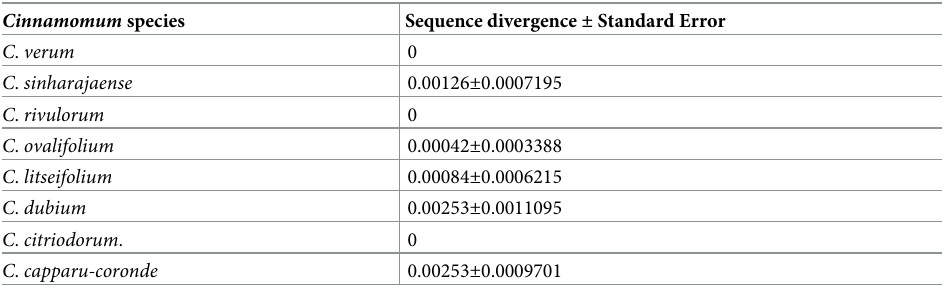
Table 4. Intraspecific sequence divergence.